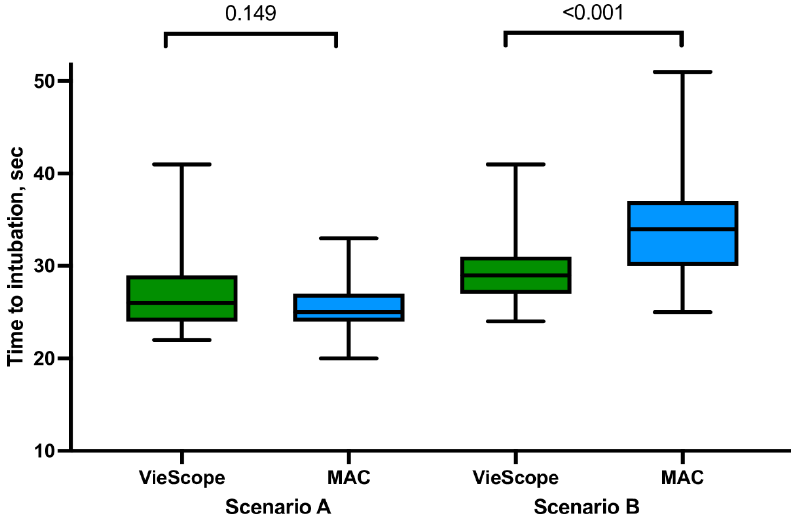
Figure 3. Time to intubation among evaluated intubation methods. Legend: MAC = Macintosh laryngoscope; Scenario A = intubation without personal protective equipment for aerosol-generating procedures (PPE-AGP); Scenario B = intubation with PPE-AGP .